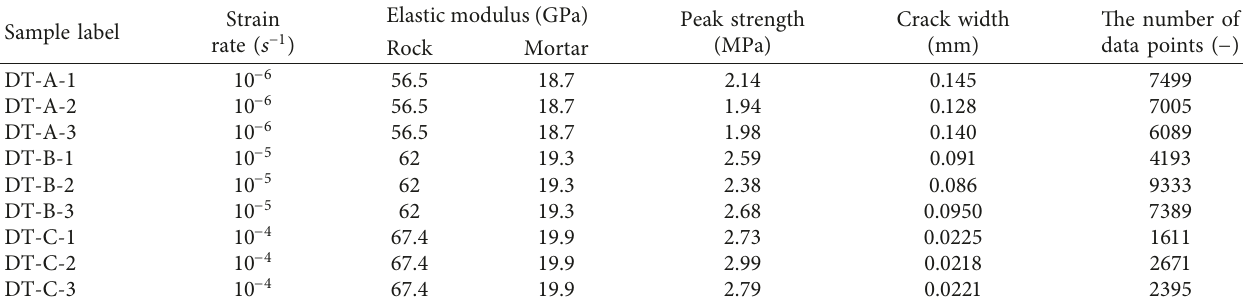
Table 1: Parameters of rock-mortar interface specimen in direct tension